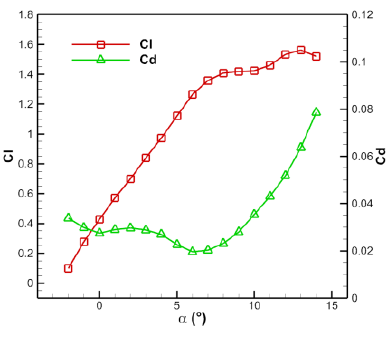
Figure 9. Aerodynamic curves of the stator.